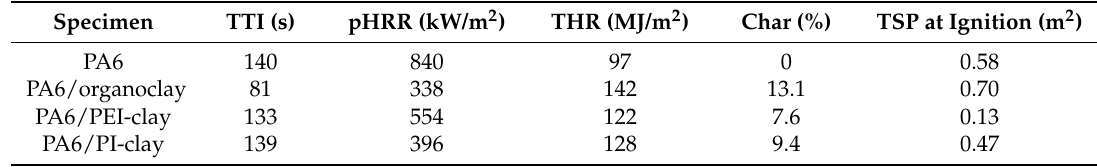
Figure 5. Heat release rate (HRR) curves for PA6 and its composites, as obtained from a cone calorimeter when exposed to a heat flux of 35 kW/m 2 . Table 3. Cone calorimeter results of neat PA6 and its composites.